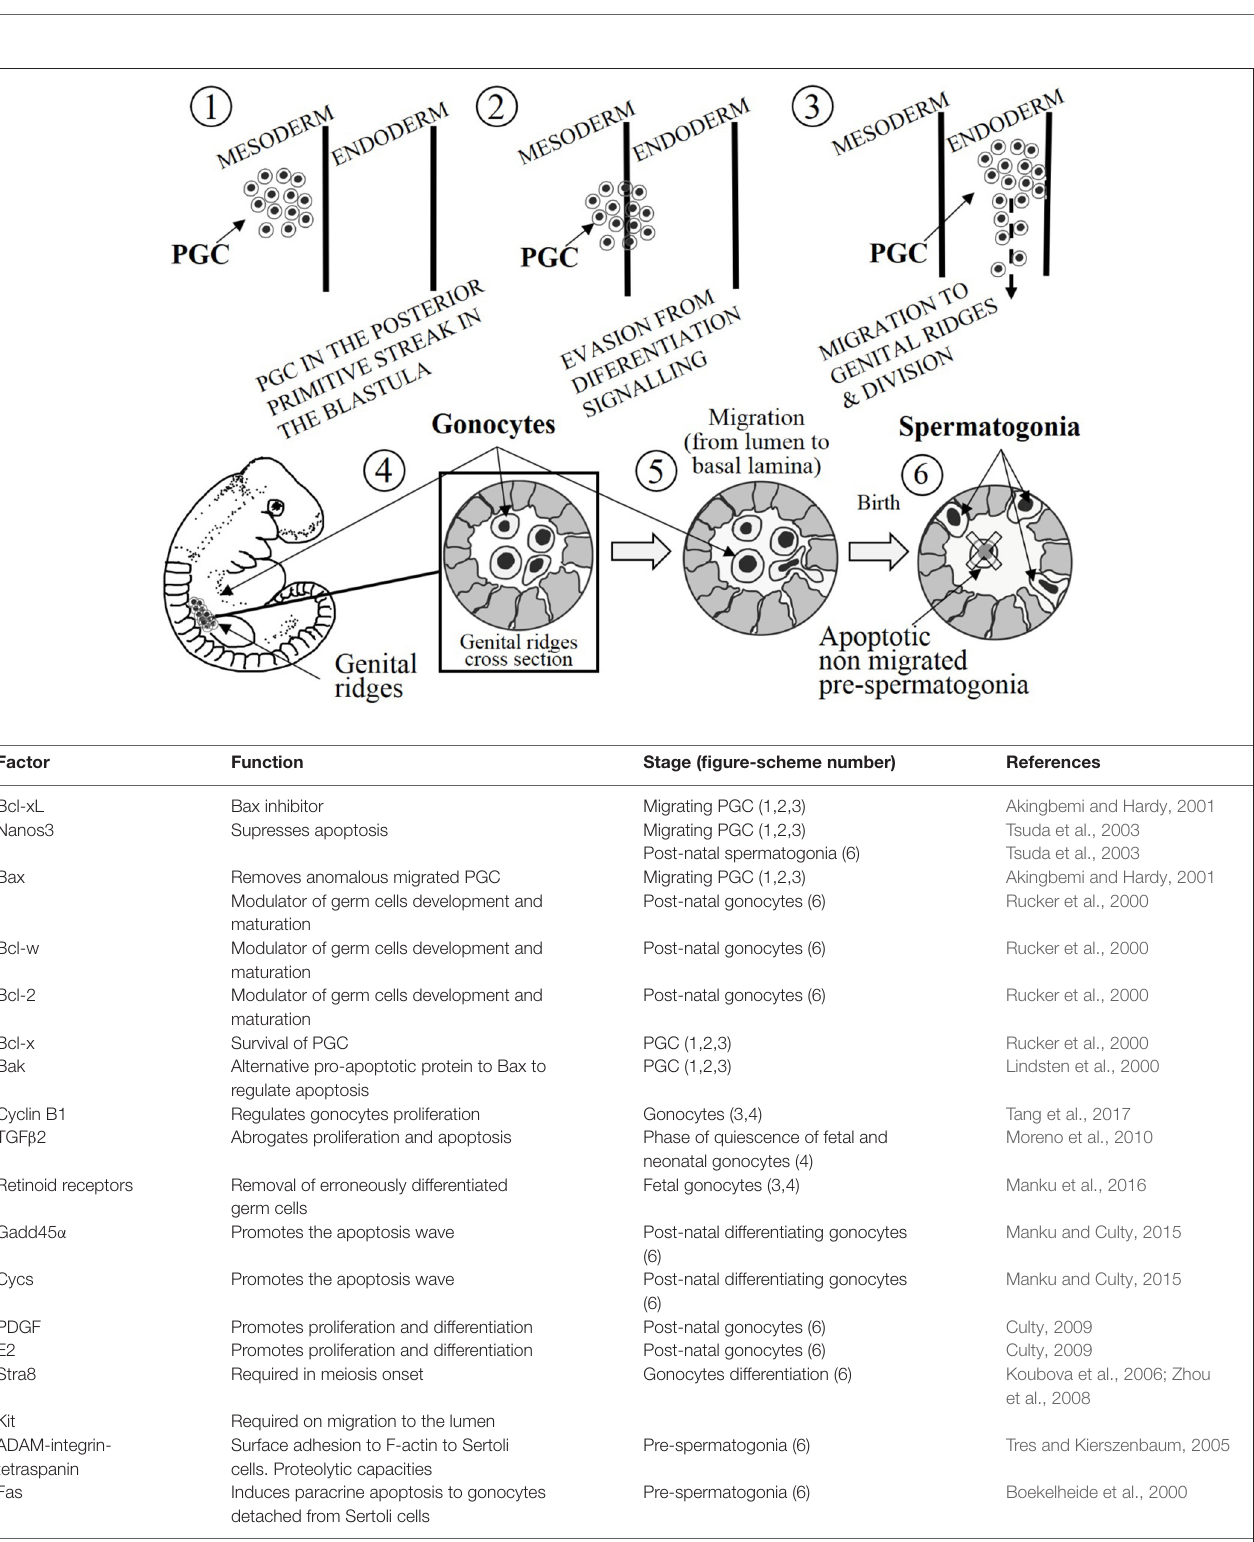
Frontiers in Cell and Developmental Biology |